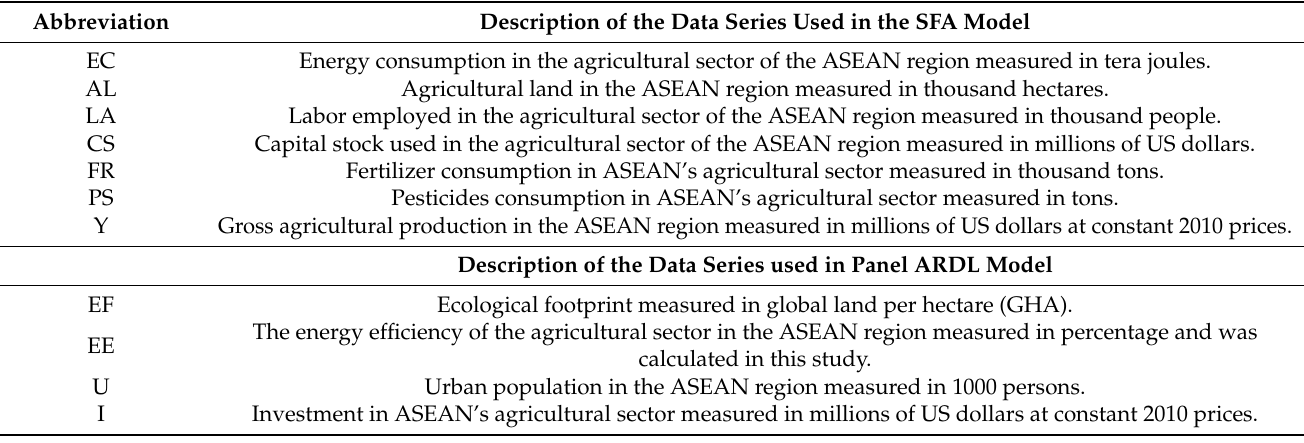
Table 1. Description of the data series used in this